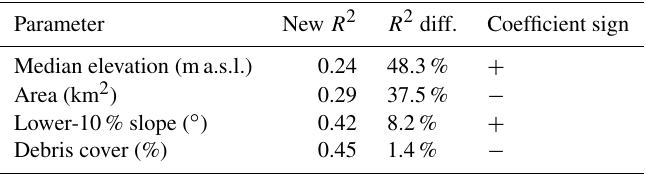
Table 3. The relative importance of each glacier variable in a multivariable regression to explain the variance of glacier mass balance (see Huss, 2012). The total R 2 of the multivariable regression using all parameters is 0.46; the “New R 2 ” column for each parameter is the explained variance when excluding the parameter in question, and the “ R 2 diff.” column is the difference in percent to the total R 2 . The coefficient sign shows if the parameter is positively or negatively correlated with glacier mass